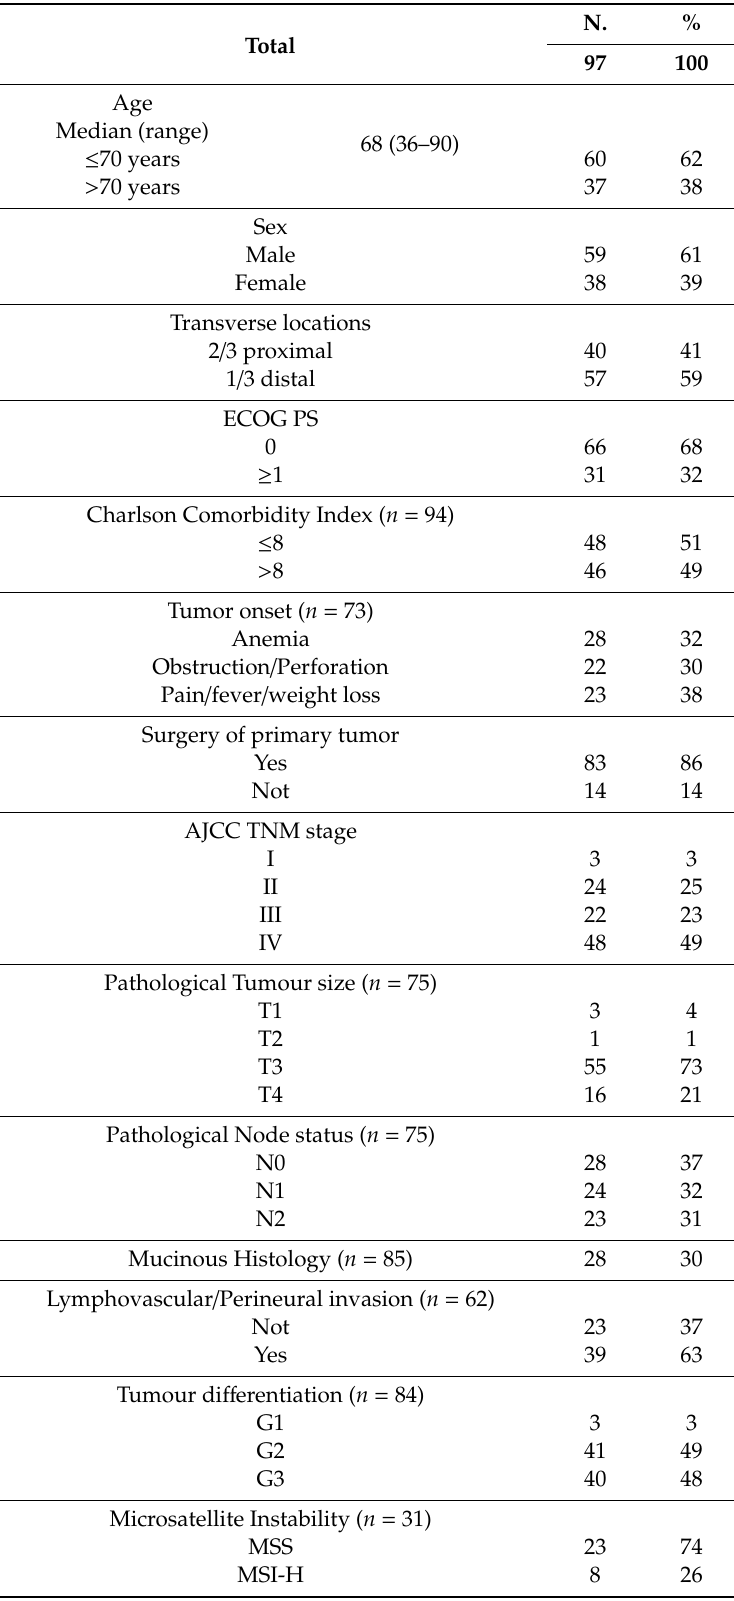
Table 1. Clinicopathologic features (valid cases and